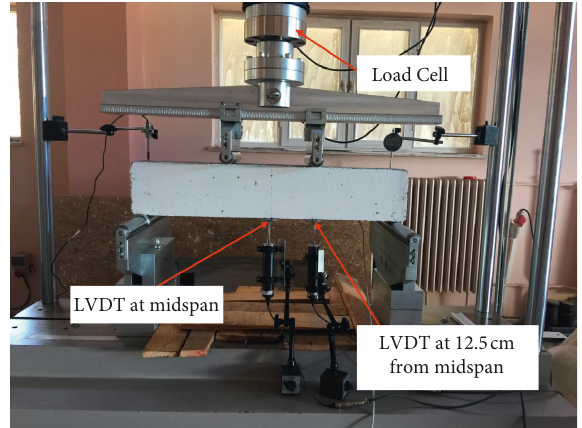
Figure 2: Test setup of the solid and hollow